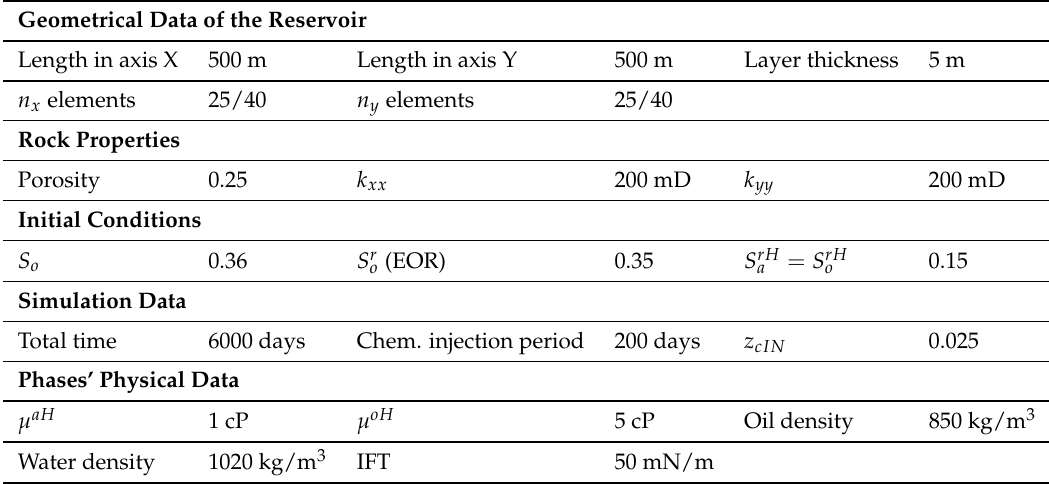
Table 1. General and initial conditions used for the